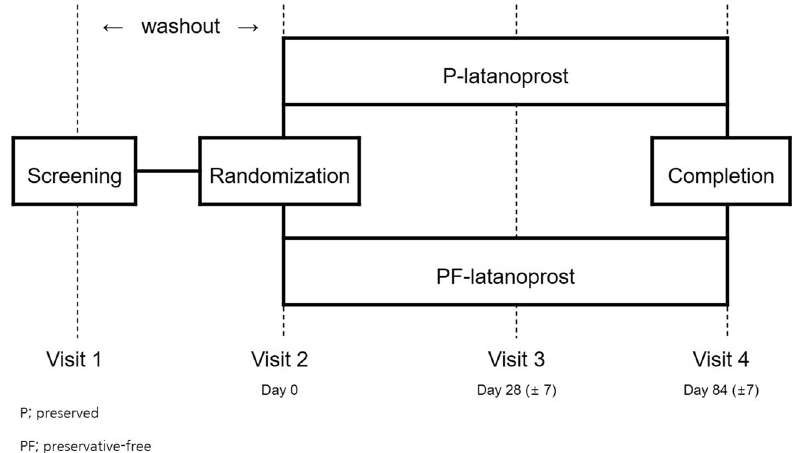
Figure 3. Follow-up schedule of the